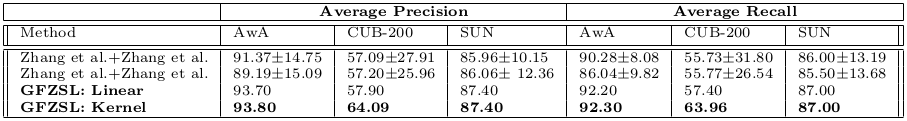
Table from the paper: A Simple Exponential Family Framework for Zero-Shot Learning
Table text:
AveragePrecision
AverageRecall
Method
AwA
CUB-200
SUN
AwA
CUB-200
SUN
Zhangetal.+Zhangetal.
91.37 ± 14.75
57.09 ± 27.91
85.96 ± 10.15
90.28 ± 8.08
55.73 ± 31.80
86.00 ± 13.19
Zhangetal.+Zhangetal.
89.19 ± 15.09
57.20 ± 25.96
86.06 ± 12.36
86.04 ± 9.82
55.77 ± 26.54
85.50 ± 13.68
GFZSL:Linear
93.70
57.90
87.40
92.20
57.40
87.00
GFZSL:Kernel
93.80
64.09
87.40
92.30
63.96
87.000